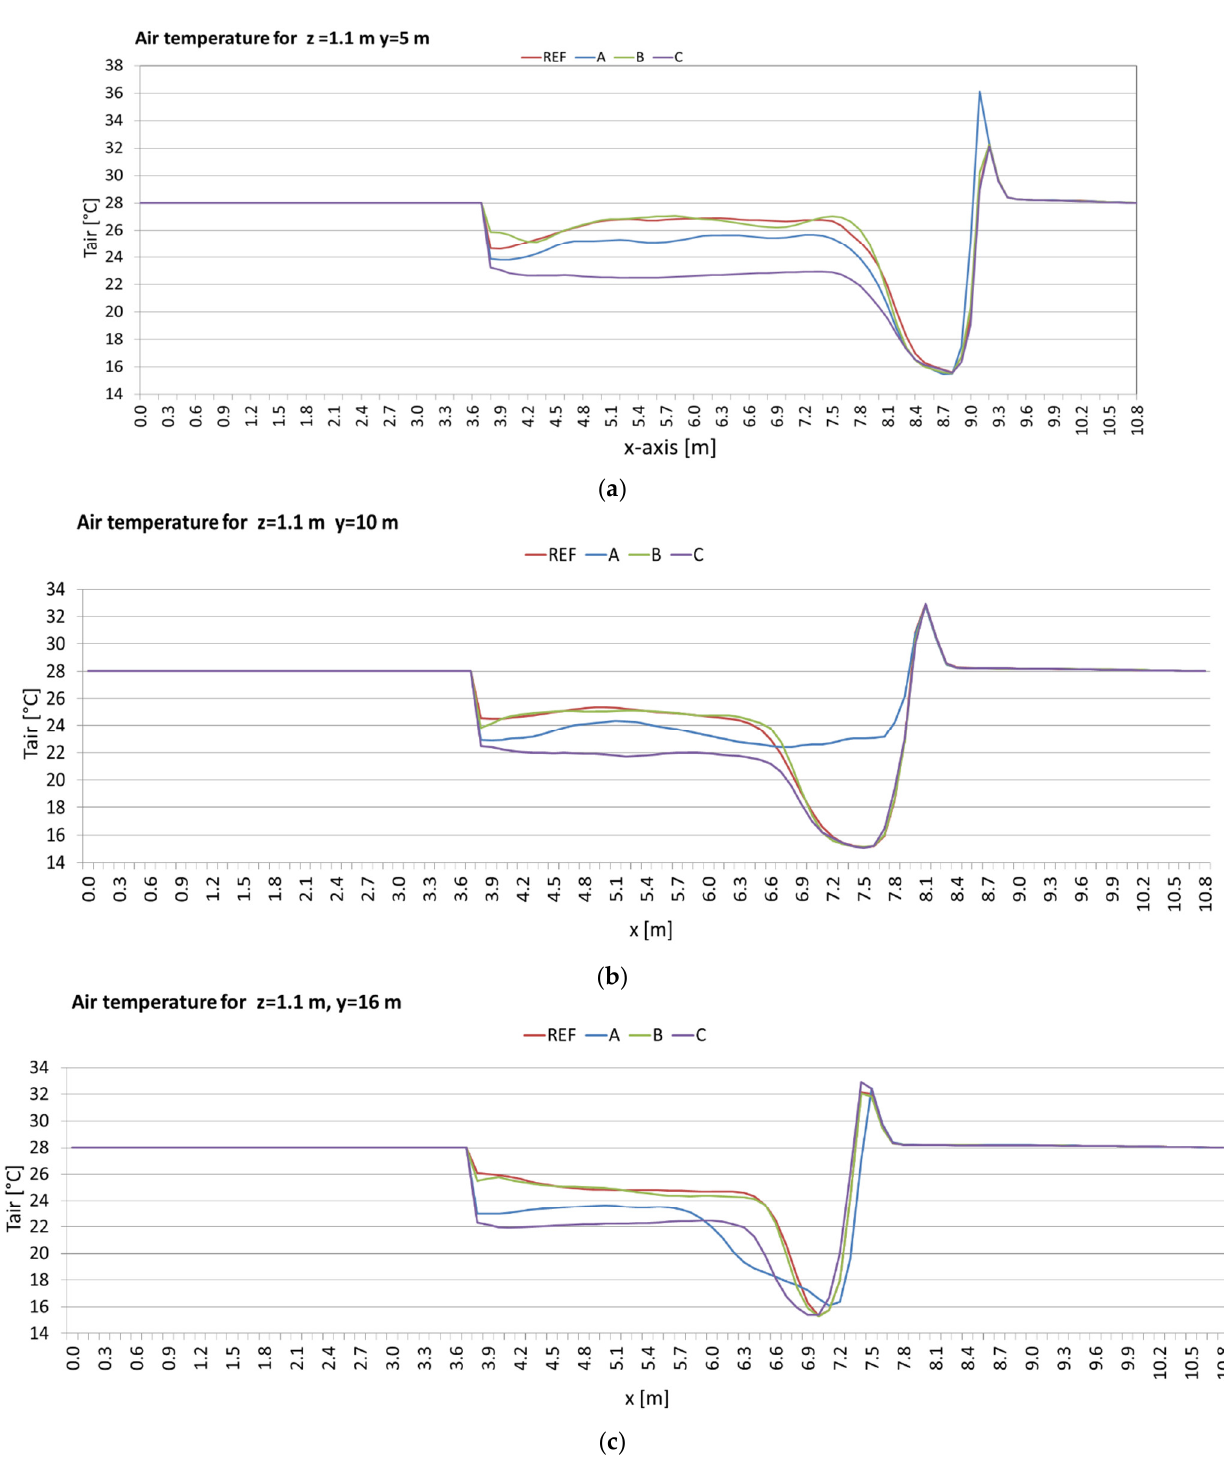
Figure 19. Comparison between the air temperatures for the four configurations (REF, A, B, and C). We compare the points at the same height (z = 1.1 m) at three different positions: y = 5 m; 10 m, and 16 m) shown in graphic ( a – c ). The width of the corridor is represented on the x axis (see the reference system in the Figure 10).